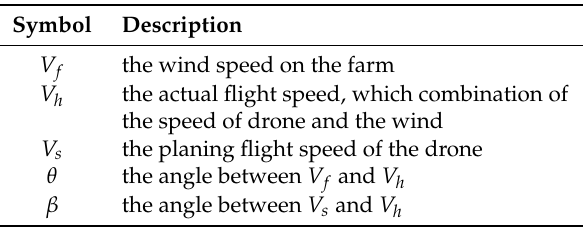
Table 1. Symbol List of Figure